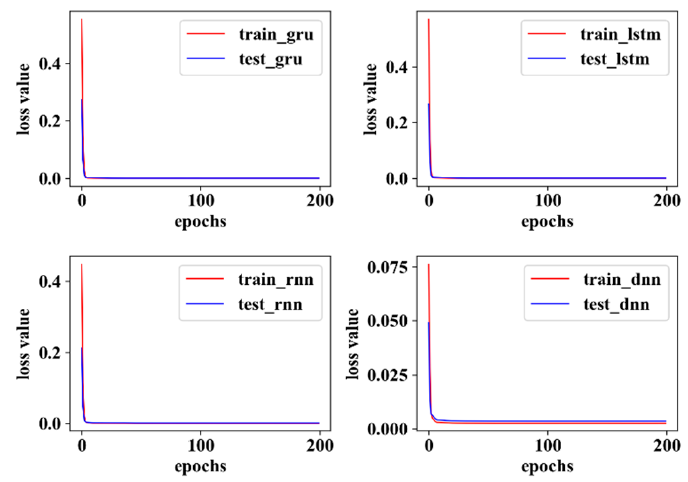
Figure 6. Loss curve of the four models.